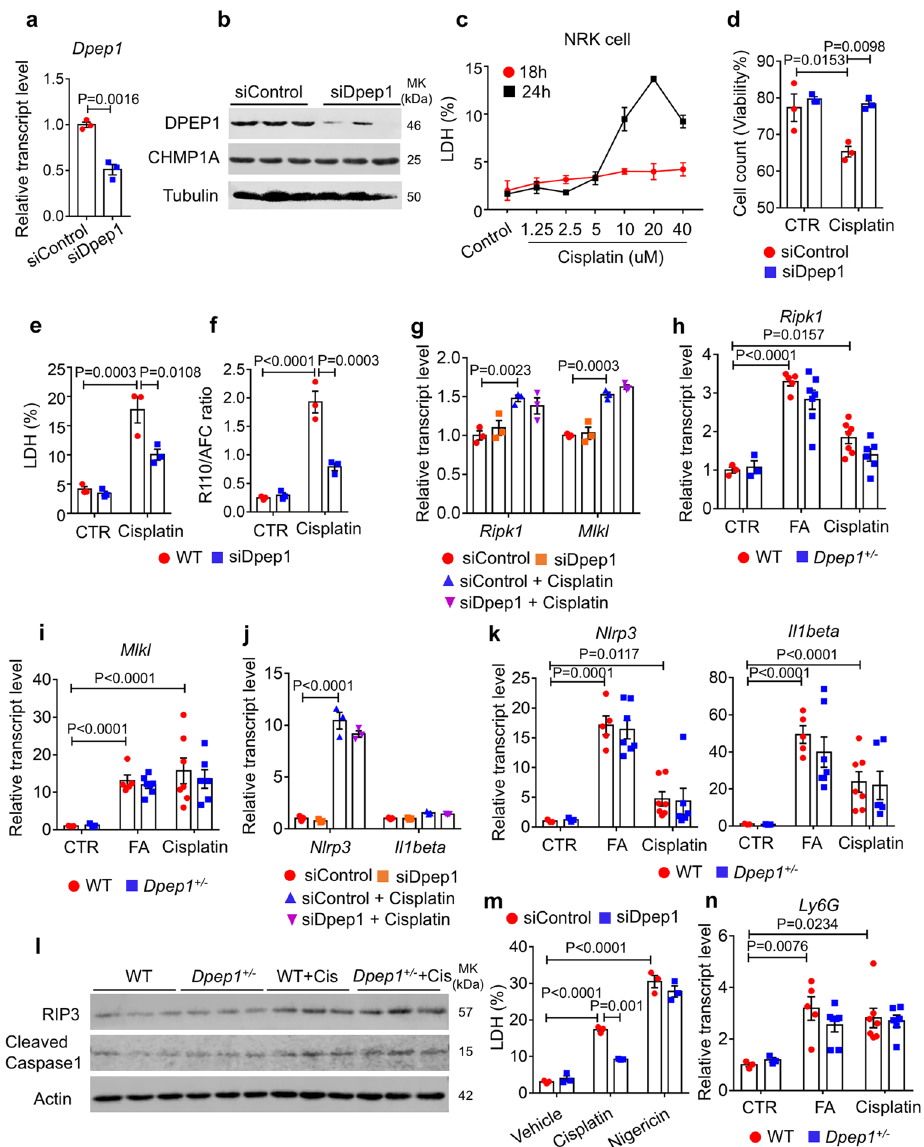
Fig. 4 Dpep1 de fi ciency protects from cisplatin-induced injury without affecting necroptosis or pyroptosis. a Relative mRNA level of Dpep1 in scramble siRNA (siControl) and Dpep1 siRNA (siDpep1) transfected tubule cell ( n = 3). b Western blots of DPEP1 and CHMP1A in scramble and Dpep1 siRNA transfected tubule cell. c LDH level of NRK52E cell treated with varying dose of cisplatin for varying degree of time ( n = 3). d The percentage of viable cells following siControl and siDpep1 transfection and in the presence and absence of cisplatin treatment ( n = 3). e LDH level of following siControl and siDpep1 transfection and sham or cisplatin treatment ( n = 3). f The ratio of cell-impermeable peptide substrate bis-AAF-R110 (dead cell indicator) to cell- permeable GF-AFC substrate (live cell indicator) from siControl and siDpep1 transfected cell following sham or cisplatin treatment ( n = 3). g Relative transcript level of Ripk1 and Mlkl of siControl and siDpep1 transfected cell following sham or cisplatin treatment ( n = 3). h Relative transcript level of Ripk1 in kidneys of folic acid and cisplatin-treated wild-type and Dpep1 + / − mice. Sham-treated group: WT ( n = 3), Dpep1 + / − ( n = 3); FA-treated group: WT ( n = 5), Dpep1 + / − ( n = 7); cisplatin-treated group: WT ( n = 7), Dpep1 + / − ( n = 6). i Relative transcript level of Mlkl in kidneys of folic acid and cisplatin-treated wild- type and Dpep1 + / − mice. Sham-treated group: WT ( n = 3), Dpep1 + / − ( n = 3); FA-treated group: WT ( n = 5), Dpep1 + / − ( n = 7); cisplatin-treated group: WT ( n = 7), Dpep1 + / − ( n = 6). j Relative transcript level of Nlrp3 and Il1beta from siControl and siDpep1 transfected cell following sham or cisplatin treatment ( n = 3). k Relative transcript level of Nlrp3 and Il1beta in kidneys of folic acid and cisplatin-treated wild-type and Dpep1 + / − mice. Sham-treated group: WT ( n = 3), Dpep1 + / − ( n = 3); FA-treated group: WT ( n = 5), Dpep1 + / − ( n = 7); cisplatin-treated group: WT ( n = 7), Dpep1 + / − ( n = 6). l Western blots of RIPK3 and cleaved caspase 1 in kidneys of wild-type and Dpep1 + / − mice following sham or cisplatin treatment. m LDH level of siControl and siDpep1 transfected cell following sham or Nigericin treatment ( n = 3). n Relative mRNA level of Ly6G in kidneys of control, folic acid and cisplatin-treated wild-type and Dpep1 + / − mice. Sham-treated group: WT ( n = 3), Dpep1 + / − ( n = 3); FA-treated group: WT ( n = 5), Dpep1 + / − ( n = 7); cisplatin-treated group: WT ( n = 7), Dpep1 + / − ( n = 6). All data are represented as mean ± SEM. P value was calculated by two-way ANOVA with post hoc Tukey test for c – n . P value was calculated by two-tailed t -test for a . P < 0.05 is statistically signi fi cant. A Source Data fi le is available for this fi